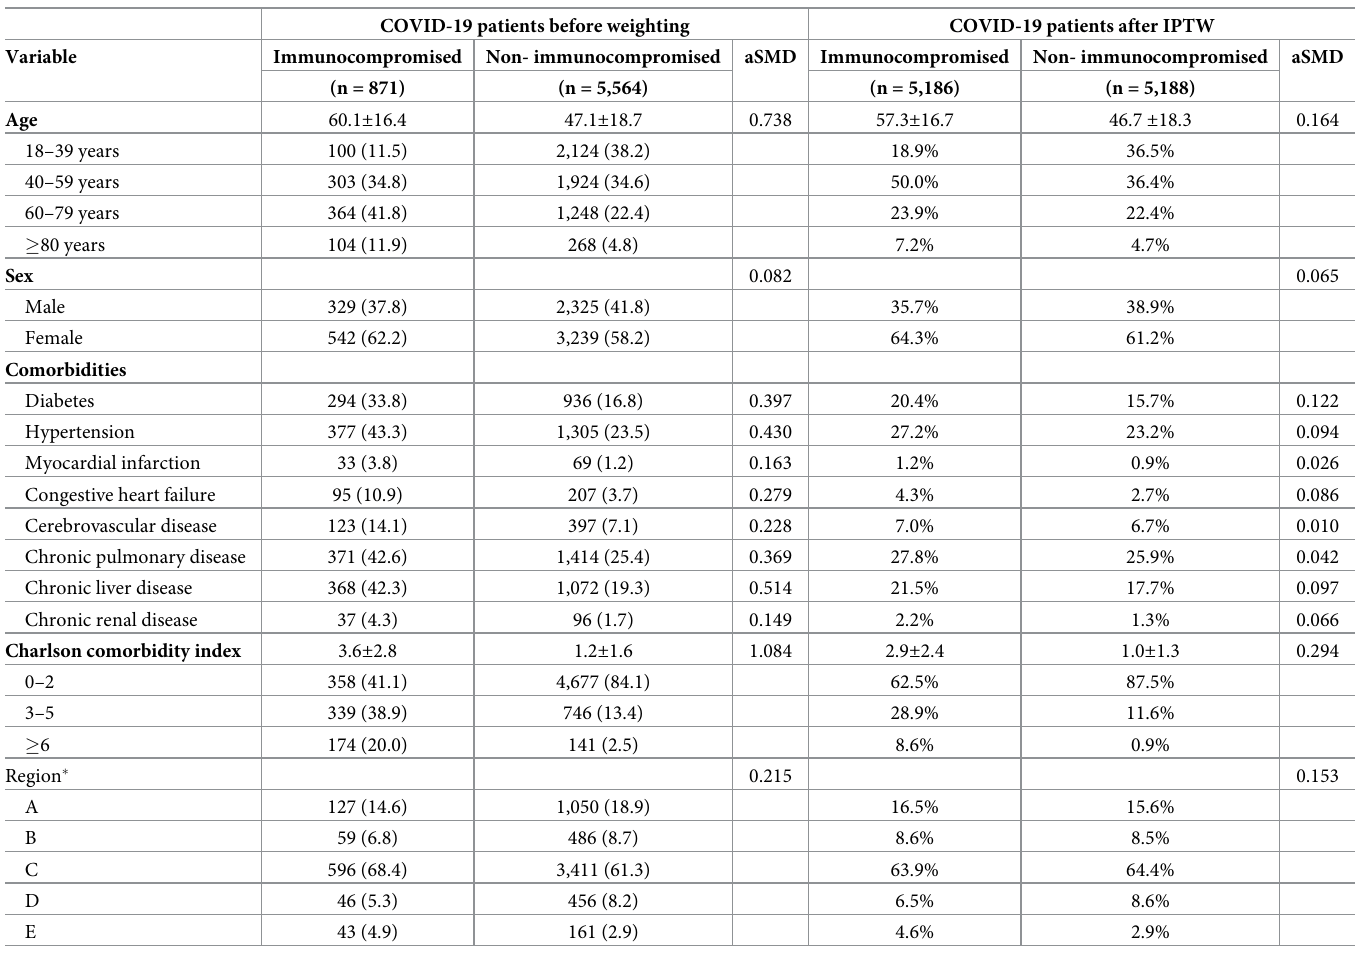
Table 1. Baseline characteristics of COVID-19